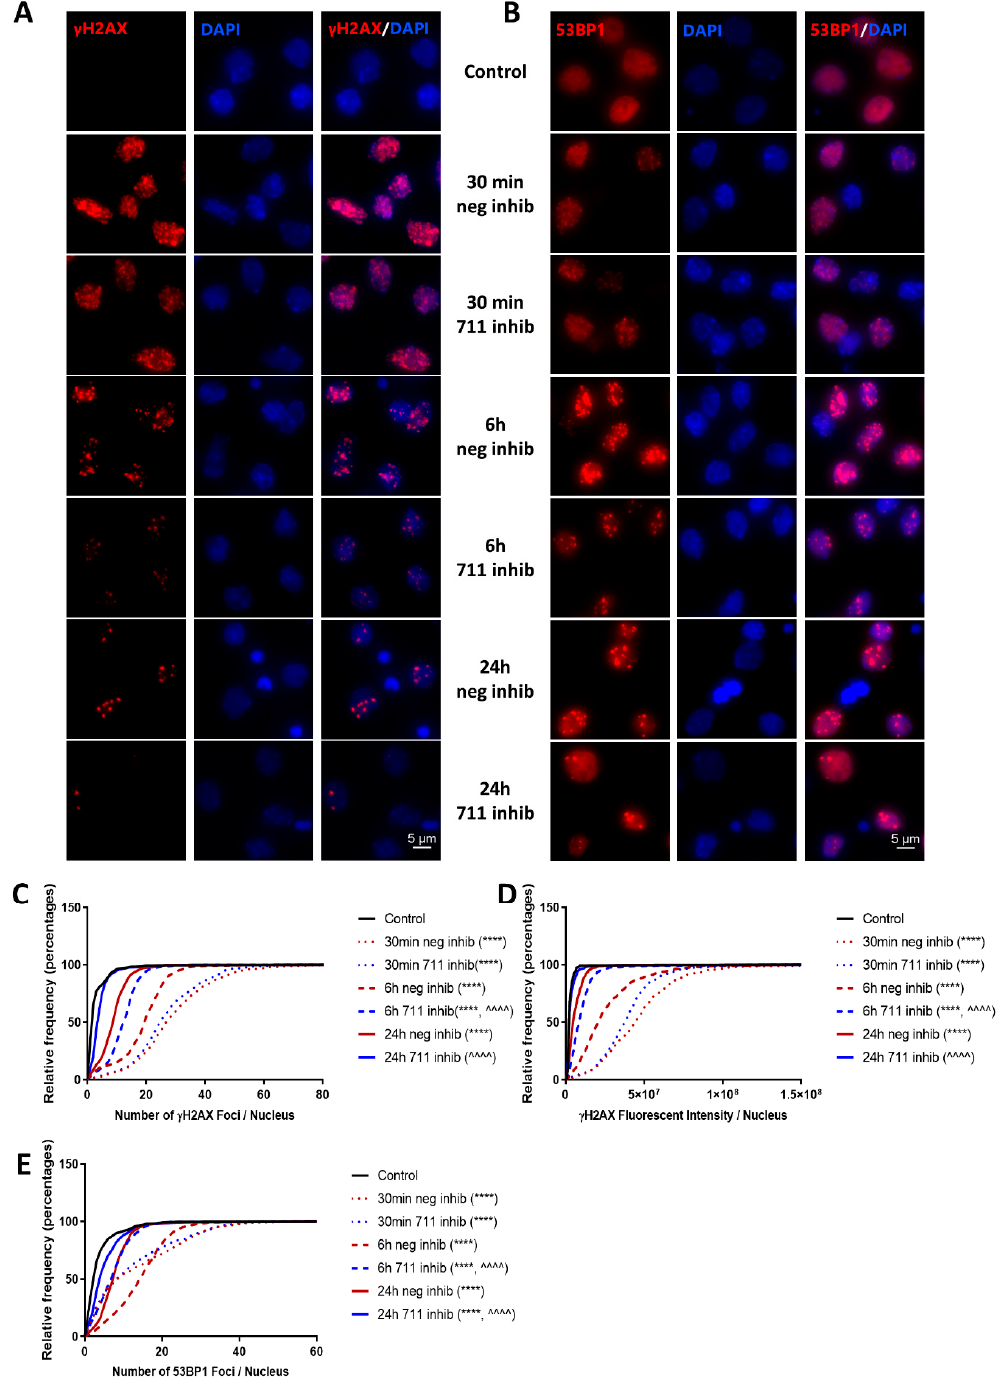
Figure 9. Representative microscopy images from 30 min, 6 and 24 h of RCNs stained for γ -H2A.X (red), and DAPI (blue) ( A ). Representative microscopy images from 30 min, 6 h and 24 h of RCNs stained for 53BP1 (red), and DAPI (blue) ( B ). Data were calculated and plotted for all fields together as a cumulative frequency distribution without binning for γ -H2A.X foci count ( C ) and nuclear